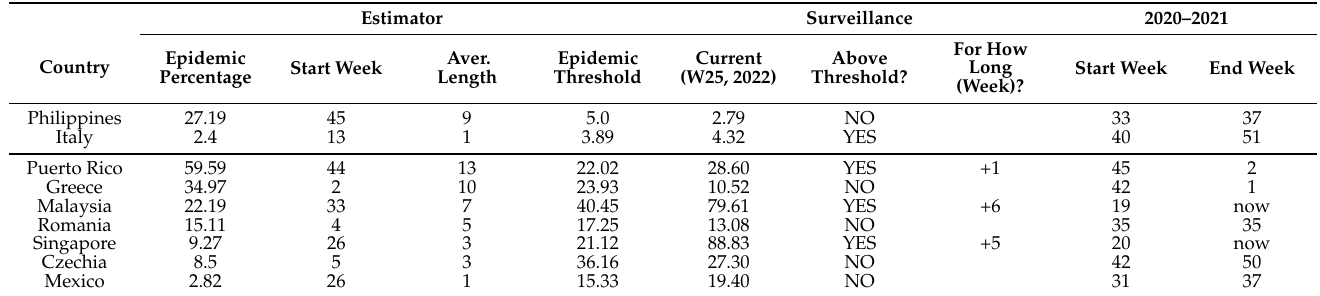
Table 2. Cont . Estimator